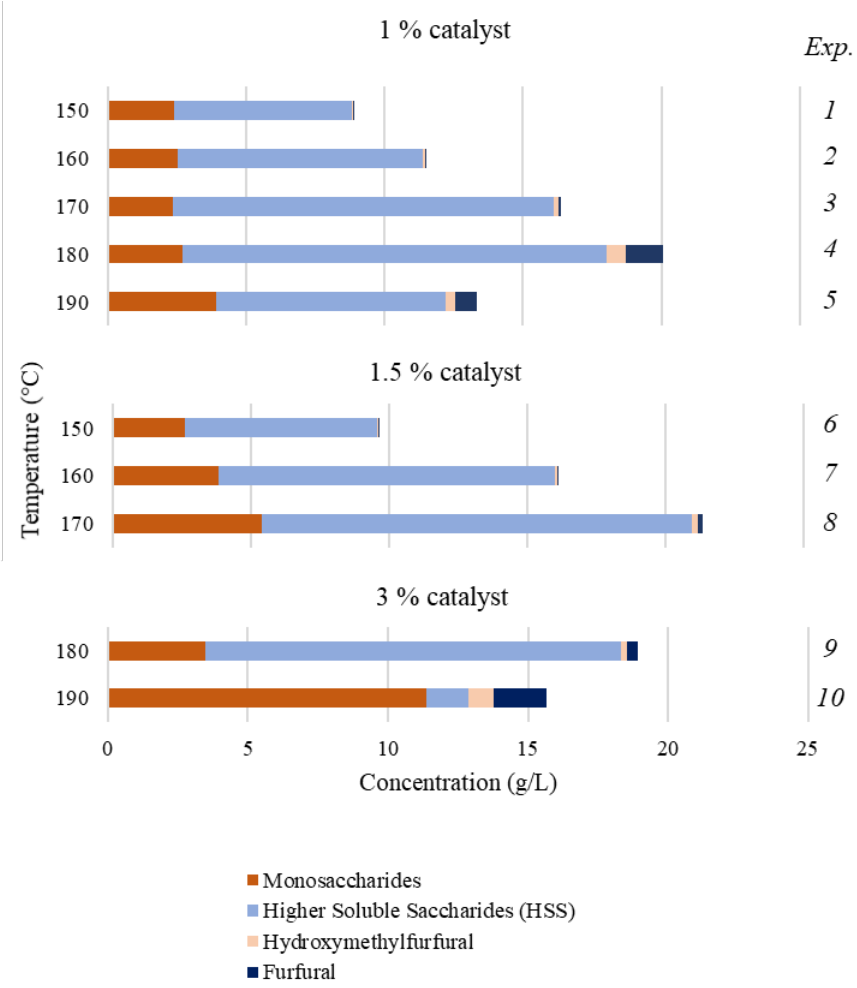
Figure 2. Concentrations of polysaccharide-derived products in the aqueous phases from AD pro- cessing obtained in experiments 1–10 in Table